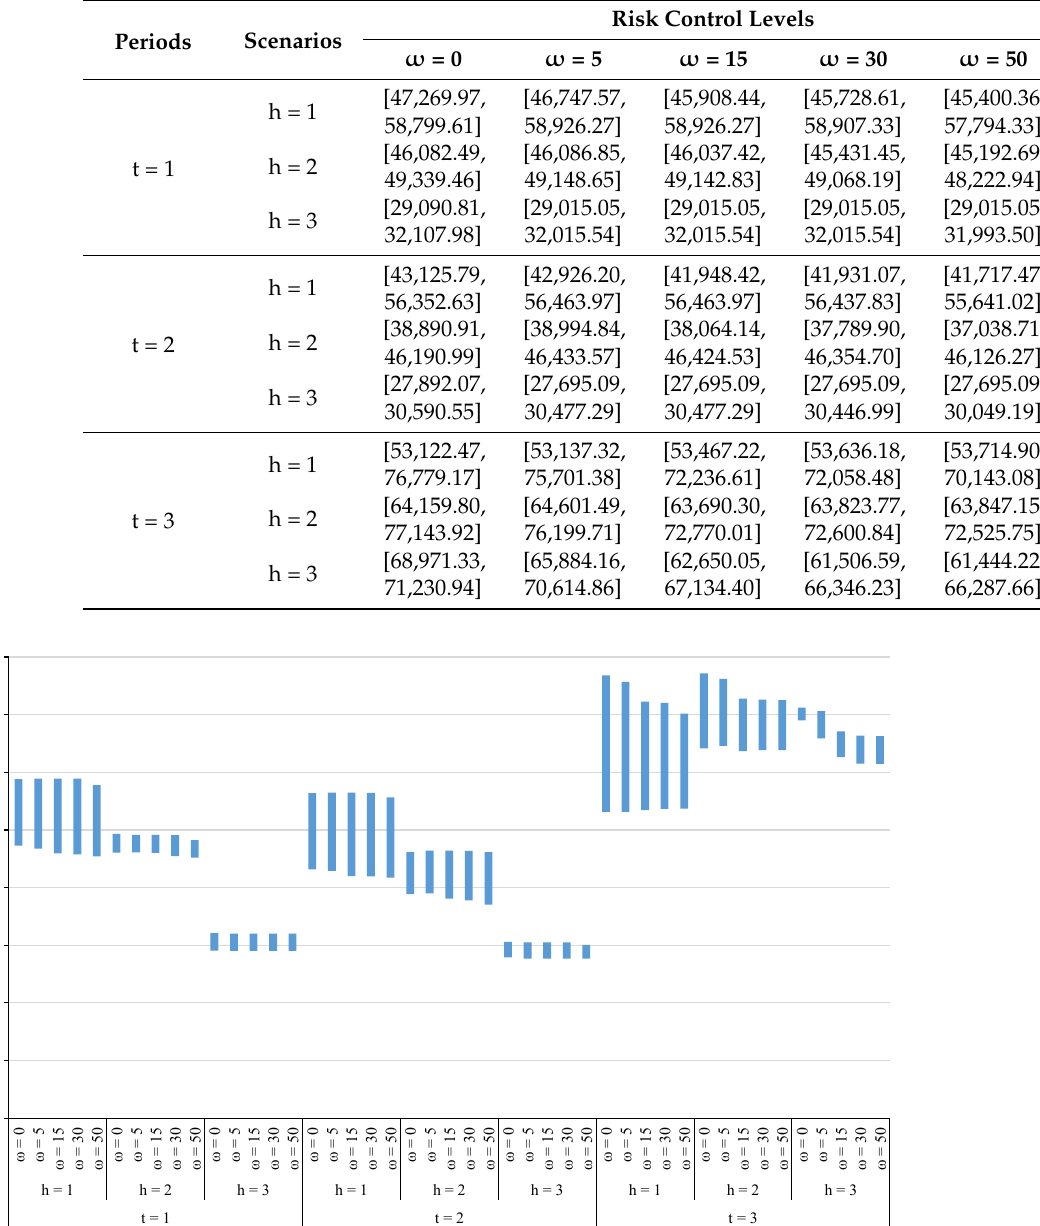
Table 4. Ecological water supply at different risk control levels in the Fenhe River Basin (10 4 m 3 ). Periods Scenarios